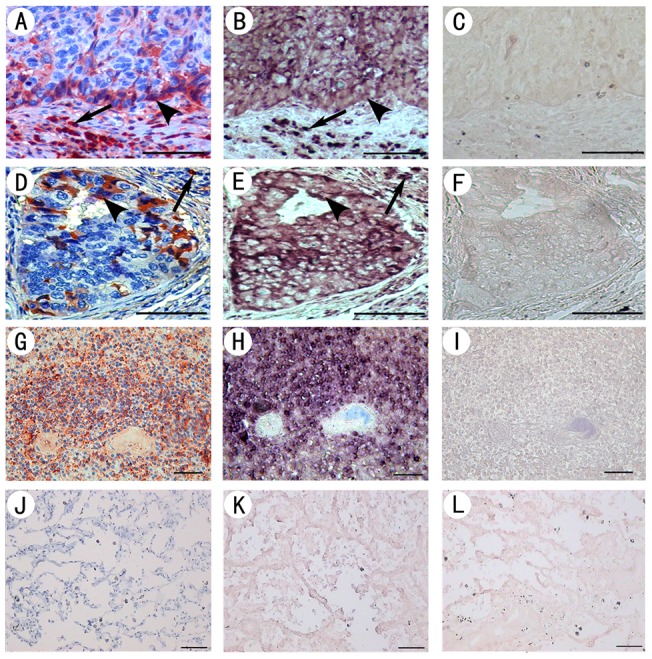
IgG expression in lung cancer tissue with IHC and ISH.Colocalization of the IgG mRNA and protein in LSCC and LAC tissue samples demonstrated with ISH and IHC. A–C, Igγ immunostaining (A, red) and mRNA signals (B, purple, with antisense probe) are positive on serial sections of a LSCC. C is a negative control with sense probe. D–F, Igγ immunostaining (D, red) and mRNA signals (E, purple, with antisense probe) are positive on serial sections of a LAC. F is negative with sense probe. G–I, Tonsil tissues are used as a positive control. G is for Igγ with IHC showing positive lymphocytes. H is for the antisense probe with ISH showing positive lymphocytes. I is with sense probe in ISH showing no positive signal. J–L, Igγ protein (J) and mRNA (K, the antisense probe) are not expressed in normal epithelial cells adjacent to tumor mass. L is the sense probe. Black arrowheads point to the same cancer cells on serial sections. Black arrows point to positive lymphocytes.